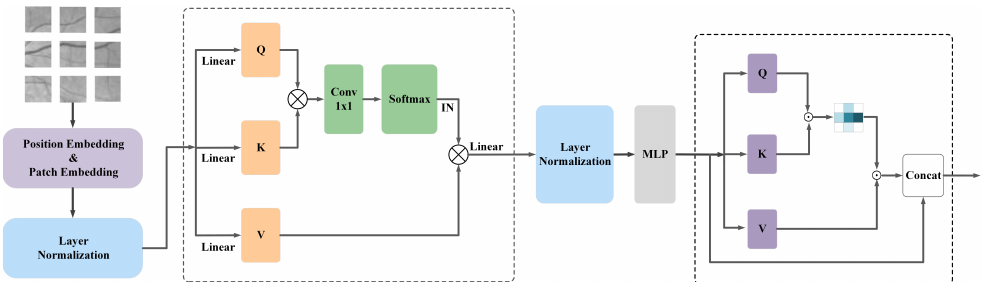
Figure 5. Structure of TPA